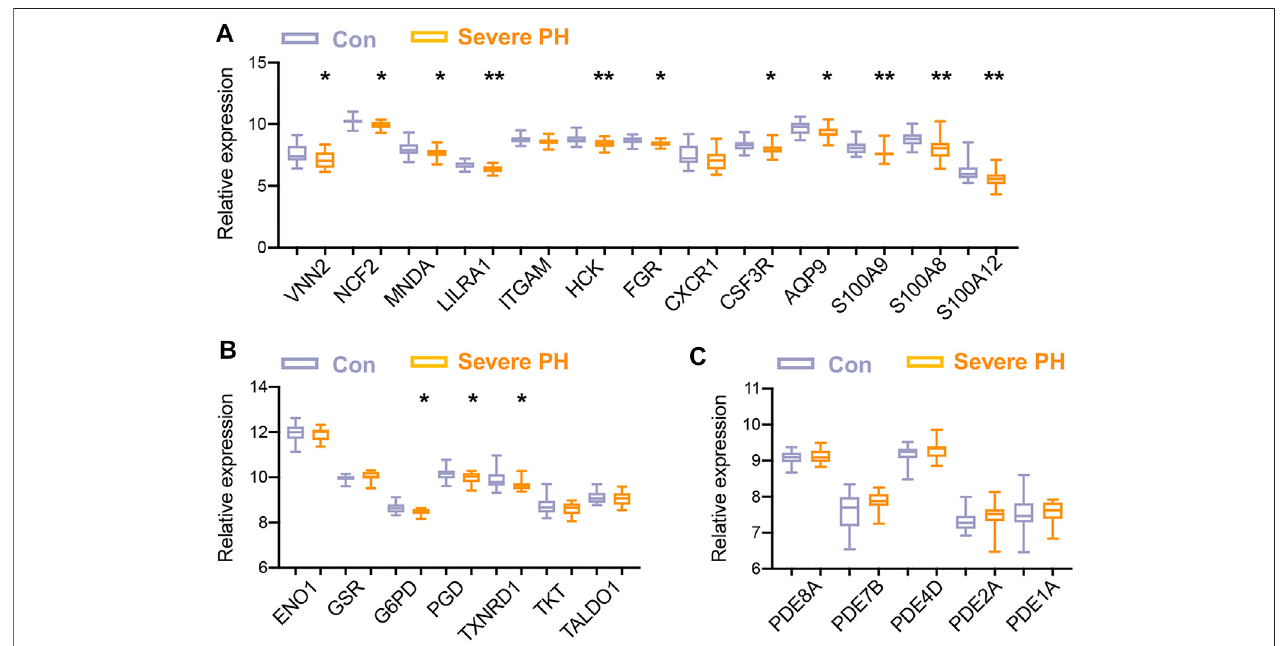
FIGURE 4 | Validation of hub TRGs in a dataset of an independent PH cohort. (A – C) Gene expression of hub TRGs in the fi rst (left) cluster (A) , hub TRGs in the second(middle)cluster (B) ,andhubTRGsinthethird(right)cluster (C) of Figure3B wereexaminedinlungs of17severePHpatientsand22controlsoftheGSE24988 dataset. Data represent mean ± SEM. * p < 0.05; ** p < 0.01 compared to control subjects, as analyzed by the unpaired t -test or Mann – Whitney test as